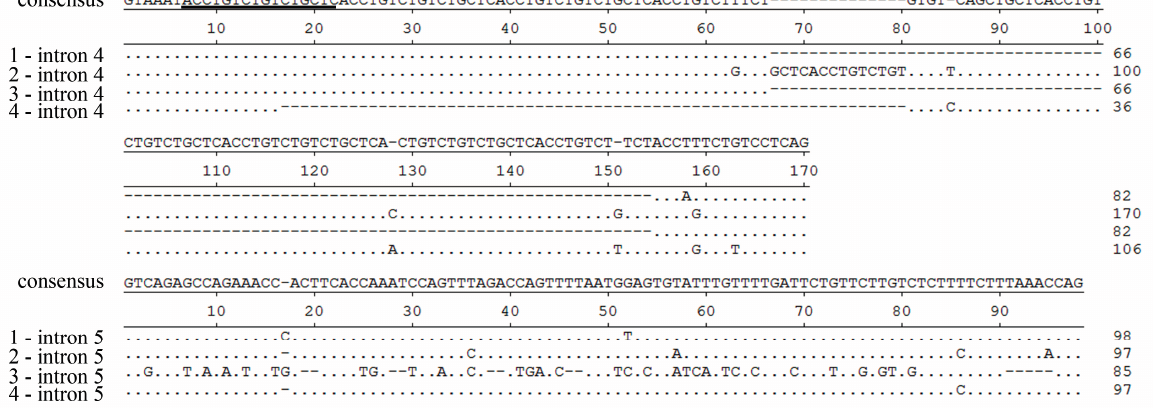
Figure 4. Intron sequences alignment of MHC class II B presumed locus 1–4 in stone flounder individual No. 3. The identical nucleotides are indicated by dots and gaps are indicated by dashes. The repeating units (GT, GTCCAGTTGA, and ACCTGTCTGTCT GCTC) in intron 2, intron 3 and intron 4 are